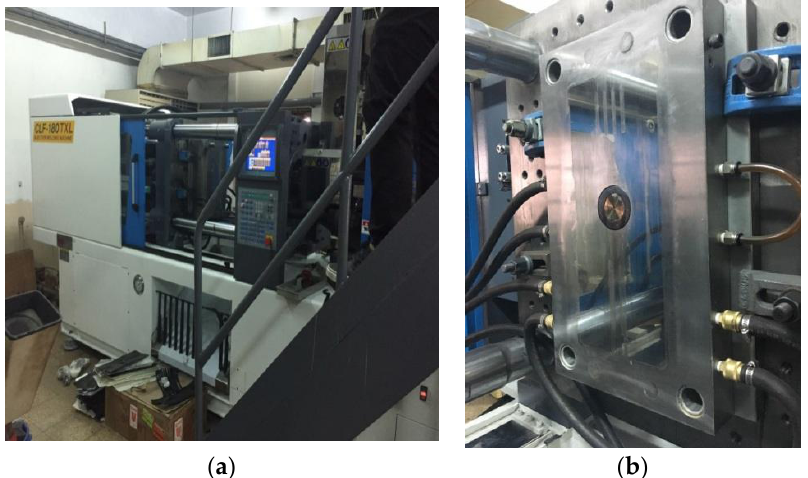
Figure 5. Machine and equipment setup: ( a ) Injection machine (Chuan Lih Fa Machinery Works Co., Model: CLF-180TXL), ( b ) the mold and cooling channel layout.